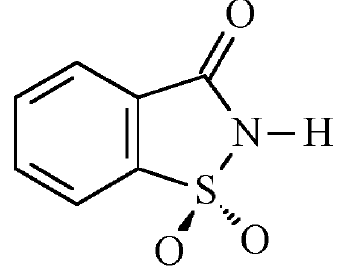
Fig. 1 Structural formula of